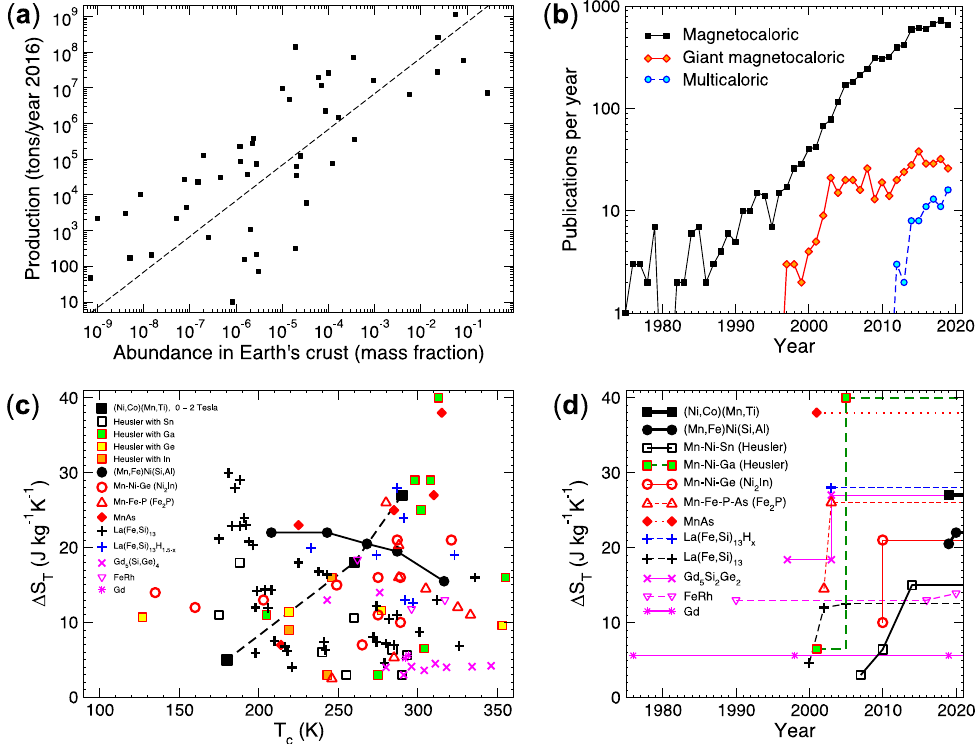
Figure 2. ( a ) Correlation between global annual production and abundance of chemical elements in the upper crust of the Earth. ( b ) The number of publications per year on magnetocalorics, a giant magnetocaloric effect and a multicaloric effect in the subject (title, abstract, and keywords) in the Web of Science core collection. ( c ) The isothermal entropy change Δ S T (J kg − 1 K − 1 ) at 2 Tesla (20 kOe) magnetic field change versus phase transition temperature T c (K). ( d ) Timeline for the selected classes of magnetocaloric materials: Δ S T at 2 Tesla near room T versus time. Viable materials made from abundant non-toxic elements are represented by black symbols. Colored are critical or toxic materials; hydrides (blue) emit H 2 gas.